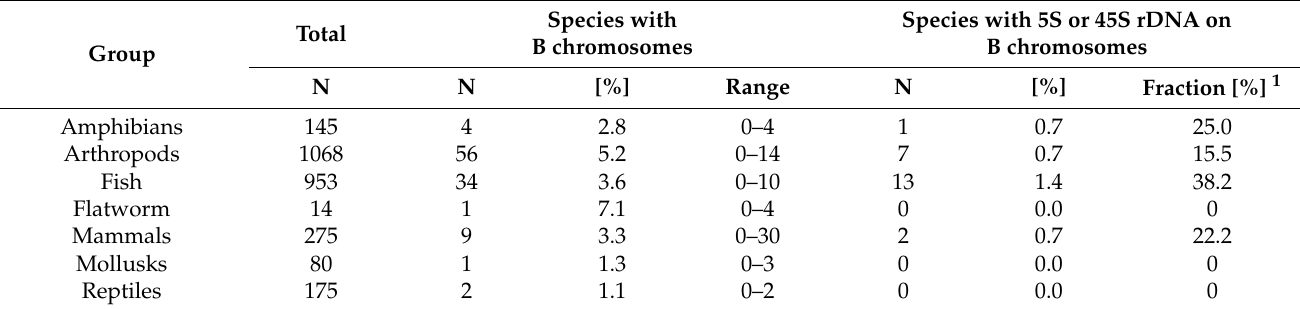
Table 3. Frequency of 5S and 45S rDNA localization on B chromosomes.